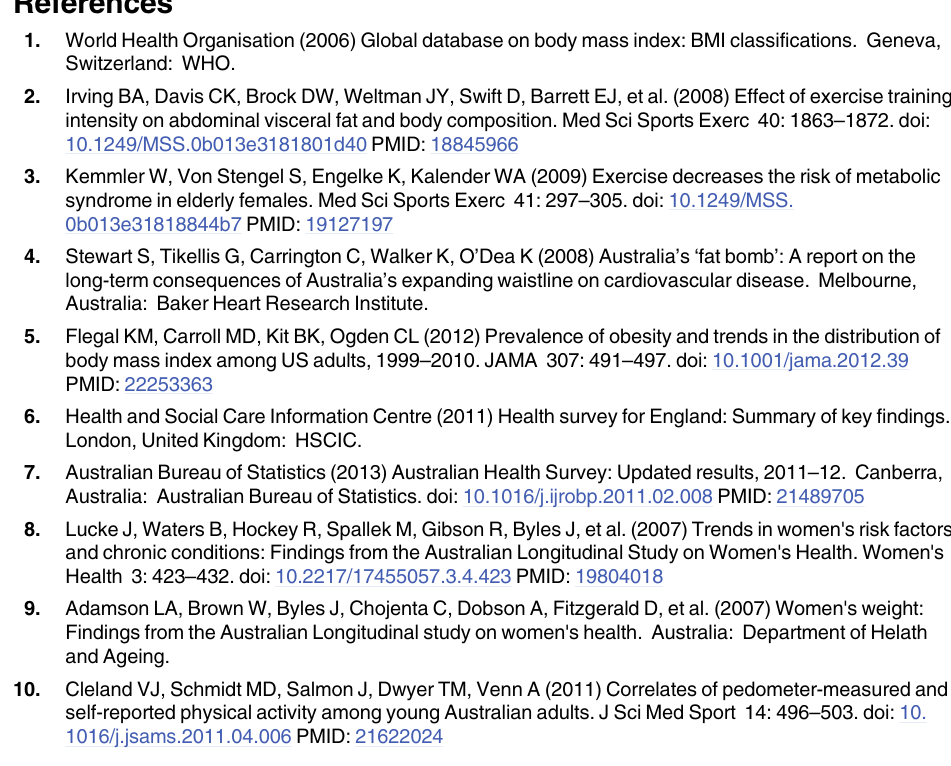
S2 Table. Lifestyle intervention: Outline of the 12-week multi-disciplinary lifestyle inter- vention of physical activity, nutrition education and cognitive behavioural